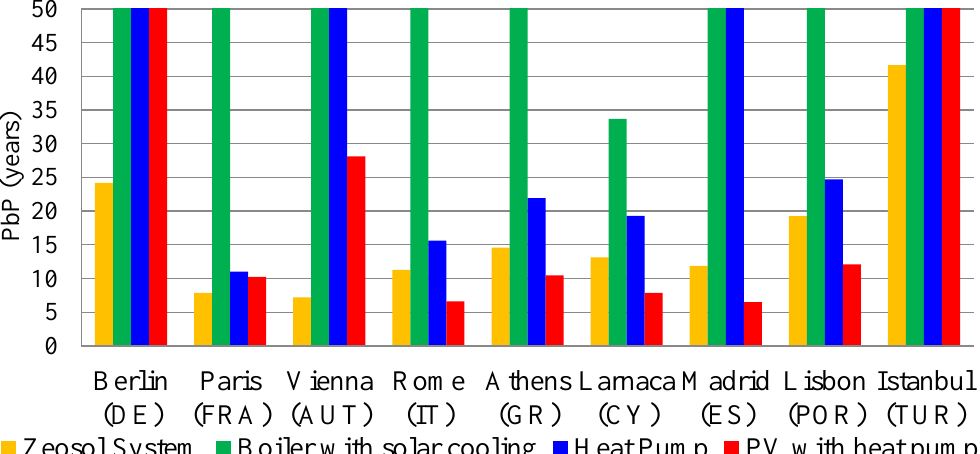
Figure 14. Economic performance of considered technologies for the investigated countries.